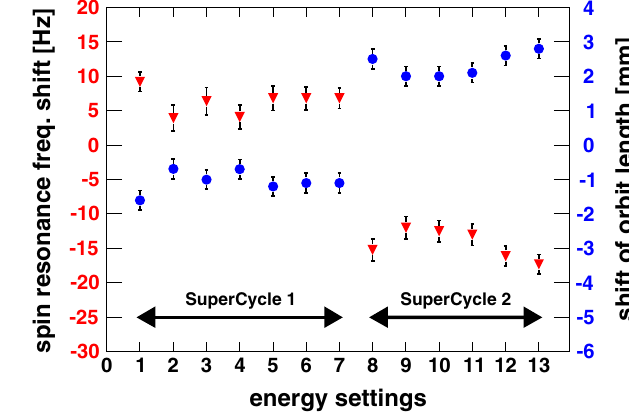
energy settings FIG. 6. (Color) The spin-resonance frequencies were measured twice, once before and once after the five days of data taking. The red triangles present the shift of the spin-resonance fre- from the first to the second measurement. These shifts quency f r correspond to changes in the orbit length, which are shown as blue circles. For the first supercycle, the spin-resonance frequen- cies decrease between the two measurements by 4–10 Hz, which corresponds to an increase in the orbit length in the range of 0.7– 1.6 mm. For the second supercycle an increase of the spin resonance in the range of 12–17 Hz was observed, i.e., a decrease in the orbit length in the range of 2.0–2.8 mm.